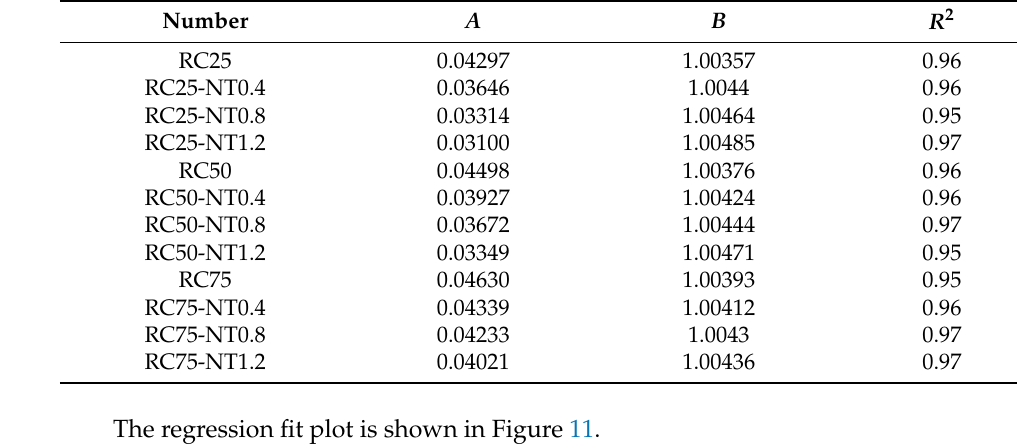
Table 9. Fitting parameters.